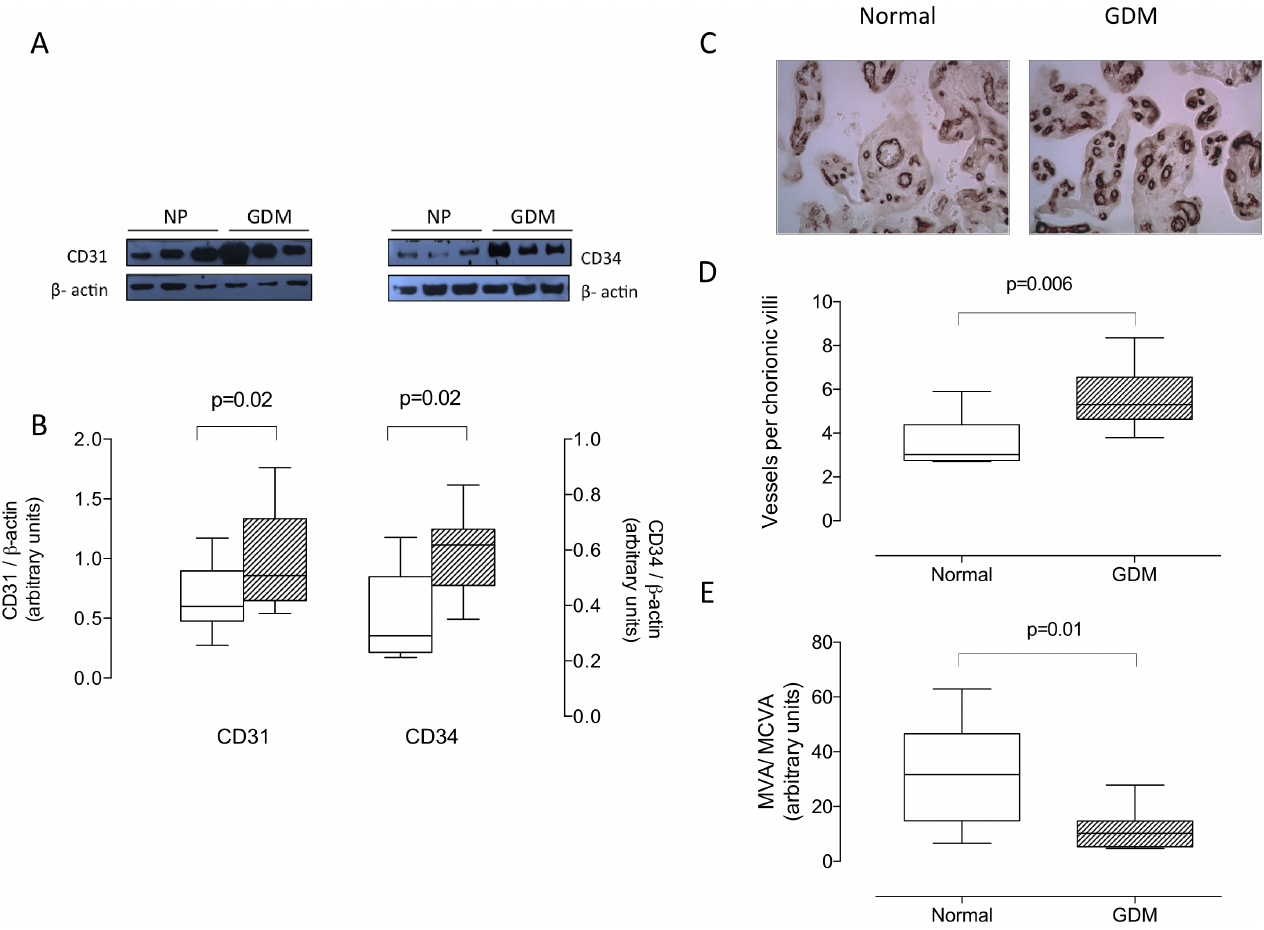
Fig 1. Placental CD31and CD34 protein. Protein levels of CD31and CD34 in total placentalhomogenates of normalpregnancy(NP, white bar) and gestational diabetes mellitus (GDM, hatchedbar) were determined by western blot. A) Representative western blot for CD31(55 kDa), CD34 (80 kDa) and β -actin (43 kDa). B) Densitometric analysisof CD31/ β -actin ratio (left Y-axis) and CD34/ β -actin ratio (right Y-axis). C) Representative images of CD34 stainingin placentasfrom Normal and GDM. D) Number of vessels per villi. E) Mean blood vessel area (MVA)/mean chorionic villi area (MCVA) ratio. In B, n = 6–12 in each group. In D and E, n = 4–5 in each group. Magnification 40X. P-value is indicatedin each